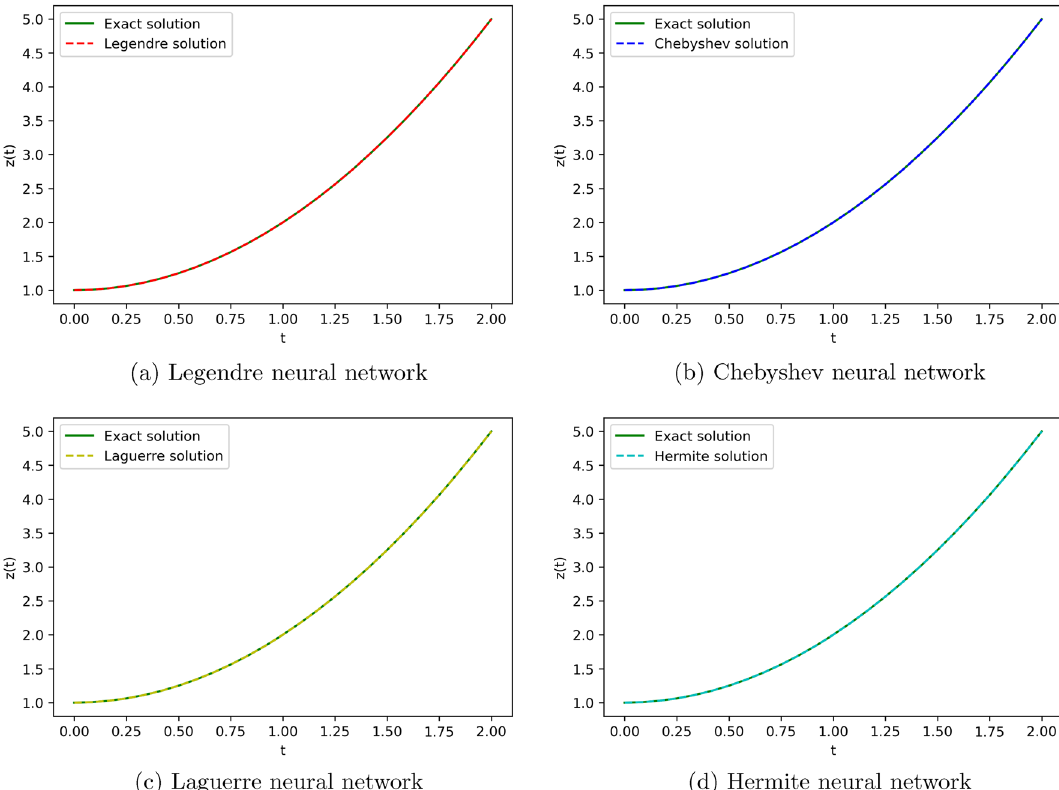
Figure 7. Comparison of the exact solution with the obtained approximate solutions of Example